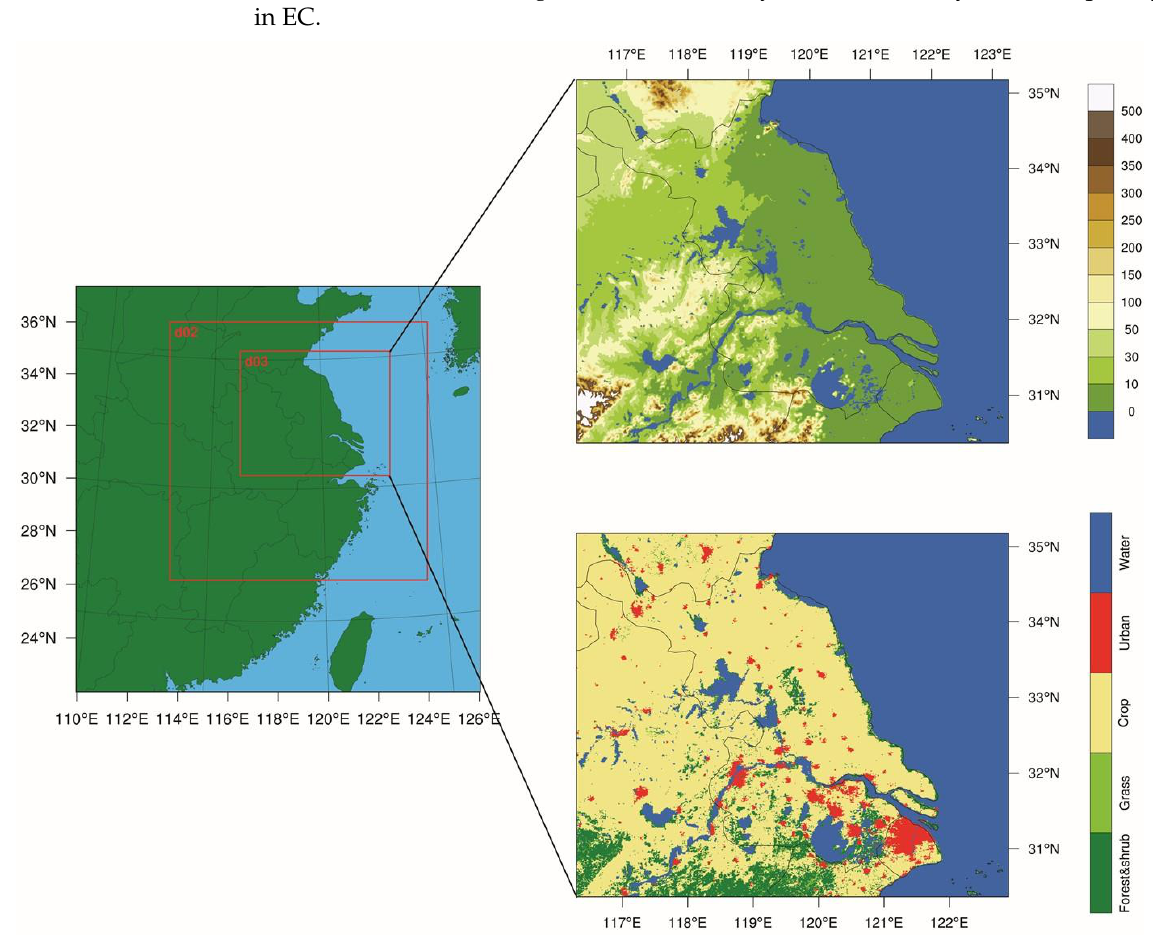
Figure 1. Three nested WRF modeling domains used for numerical simulation, topography height (unit: m), and the main land-use categories in the third domain.